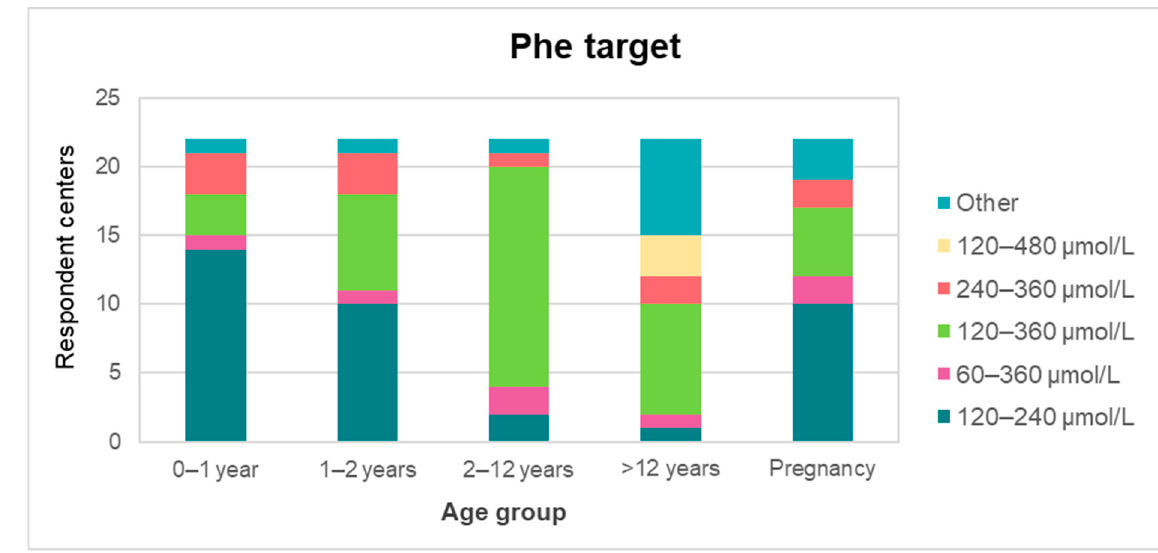
Figure 2. Target Phe levels during treatment in different age groups, as adopted by the studied centers ( n = 22). Phe: phenylalanine.